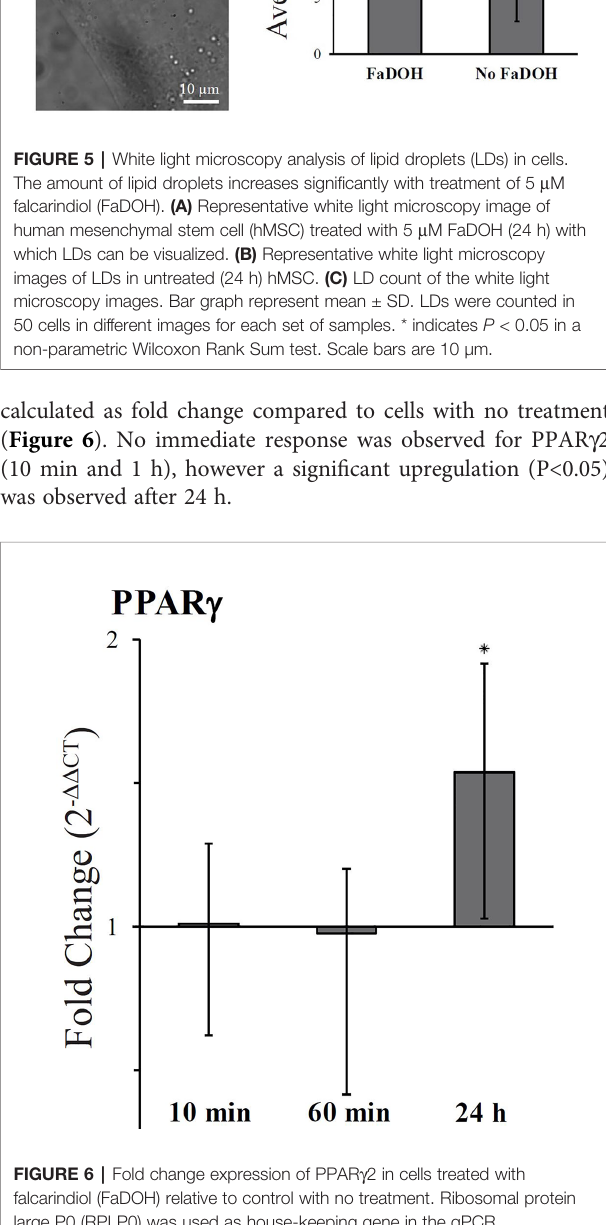
FIGURE 6 | Fold change expression of PPAR g 2 in cells treated with falcarindiol (FaDOH) relative to control with no treatment. Ribosomal protein large P0 (RPLP0) was used as house-keeping gene in the qPCR quanti fi cation. Bars represent mean ± SD. * indicates P < 0.05.